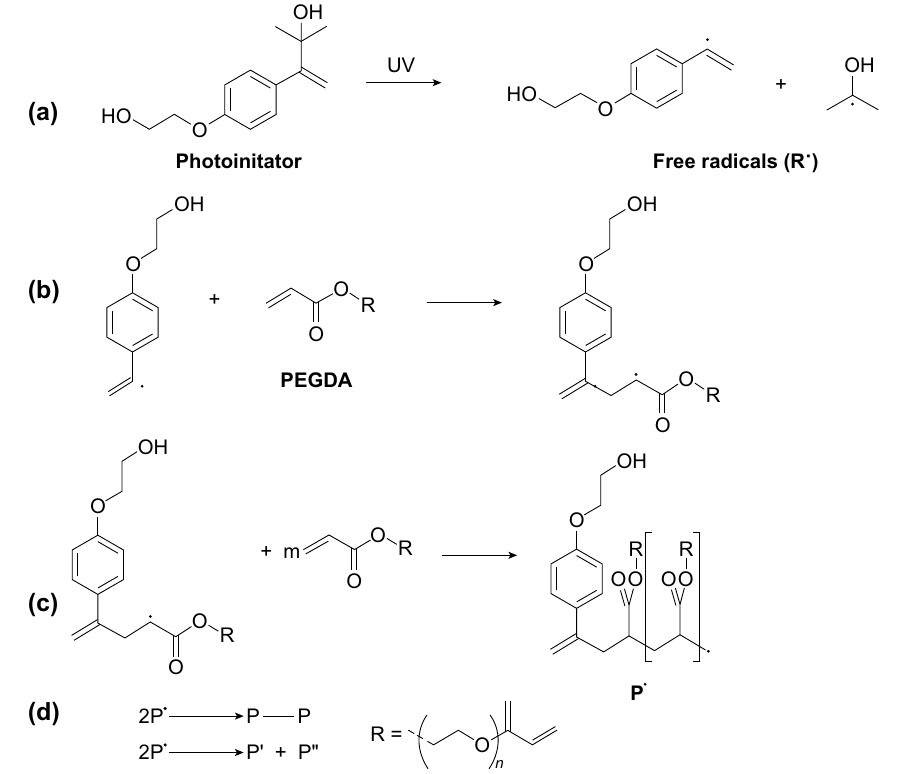
Fig. 1 Photocrosslinking mechanism of PEGDA. a UV-induced dissociation of photoinitiator to generate free radicals. b Propagation step, where free radical attacks the double bond in PEGDA to form new radicals. c Chain transfer. d Different combinations of free radicals to form stable, inactive products, thereby leading to chain termination